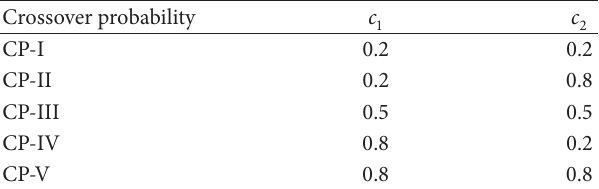
Table 3: Crossover probability.